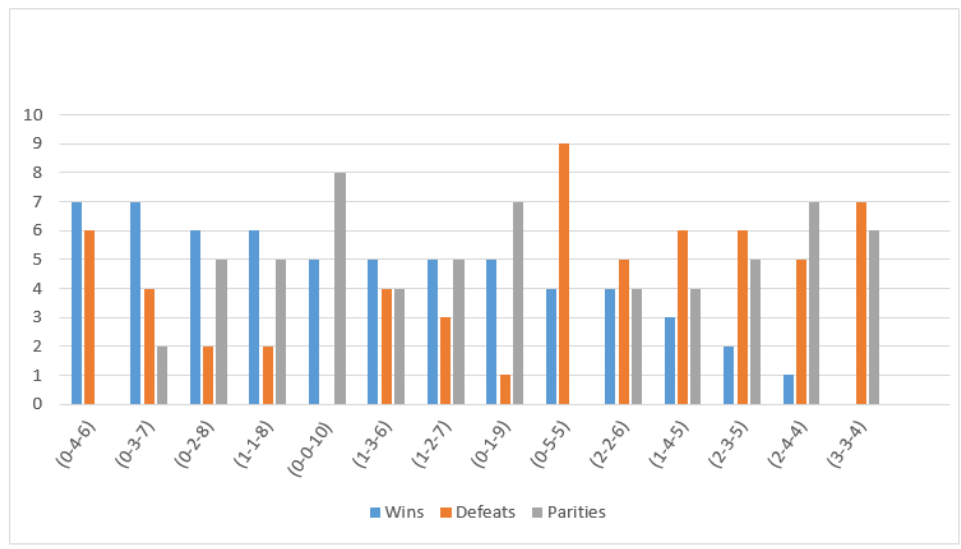
Figure 3. Graphical representation of the simulation result with heterogeneous fields and homogeneous resources.